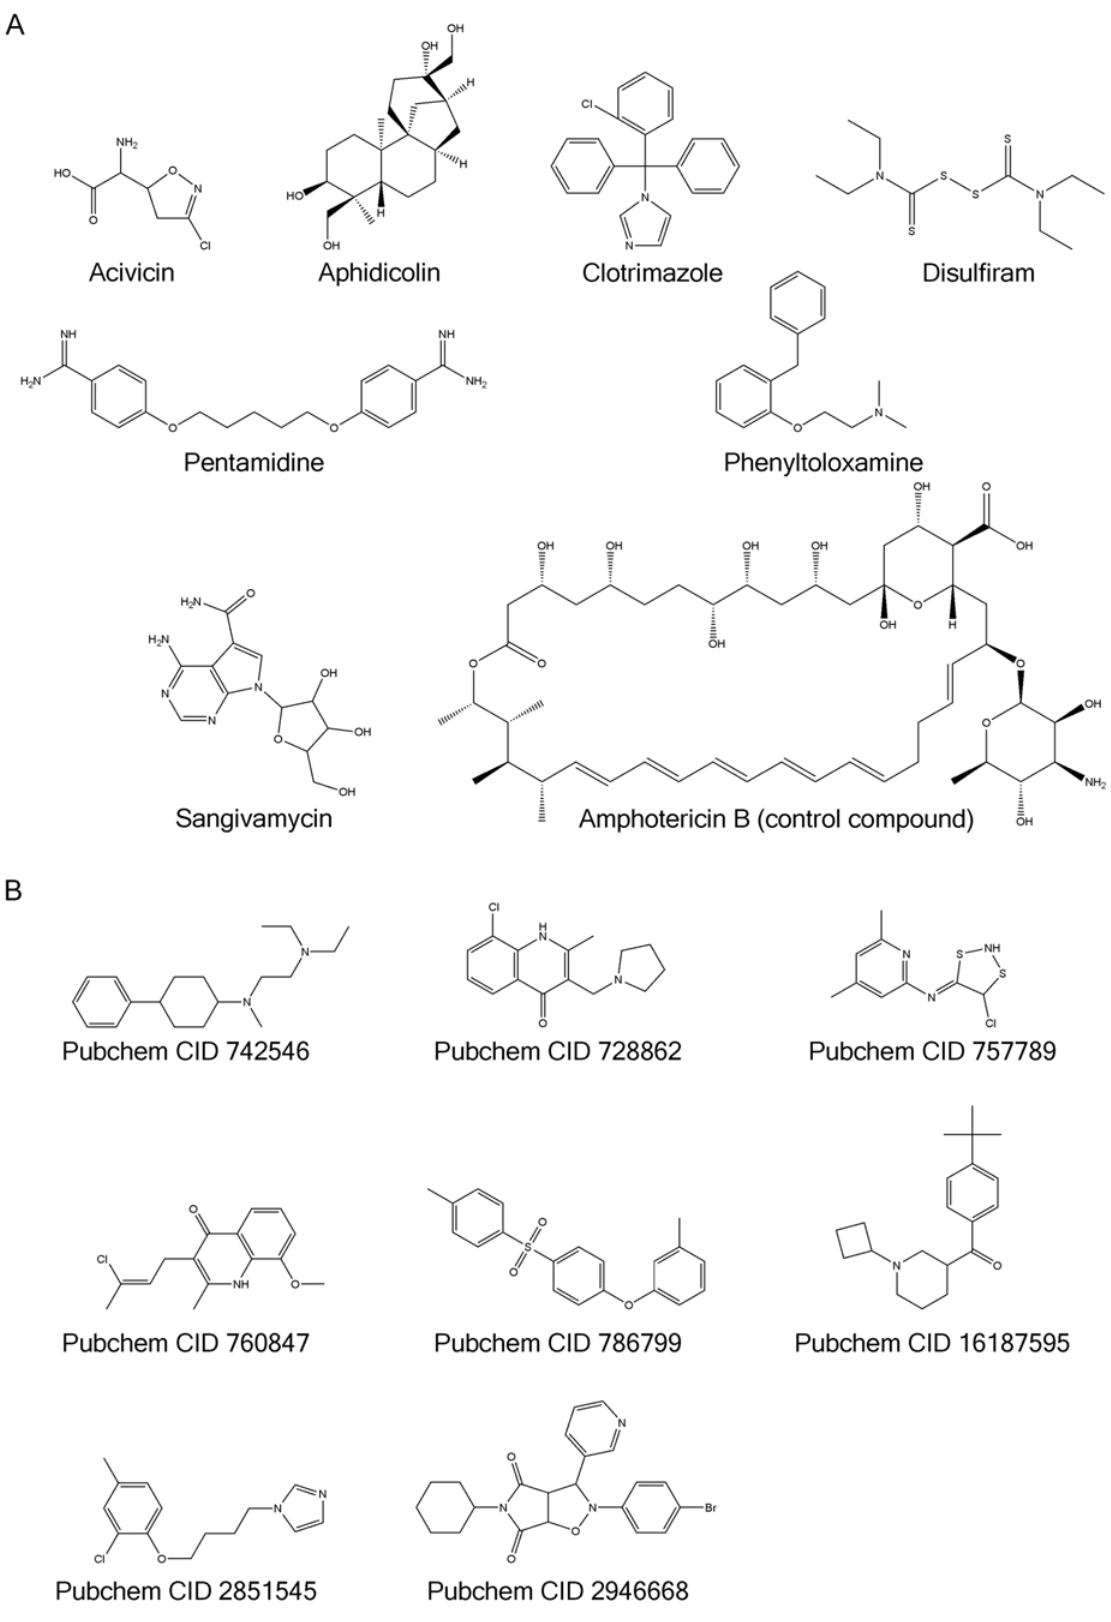
Figure 3. Chemical structures of test compounds. Structures of the 15 representative compounds tested empirically. Panel A, Compounds of known pharmacological action. Panel B, Compounds of unknown pharmacological action.